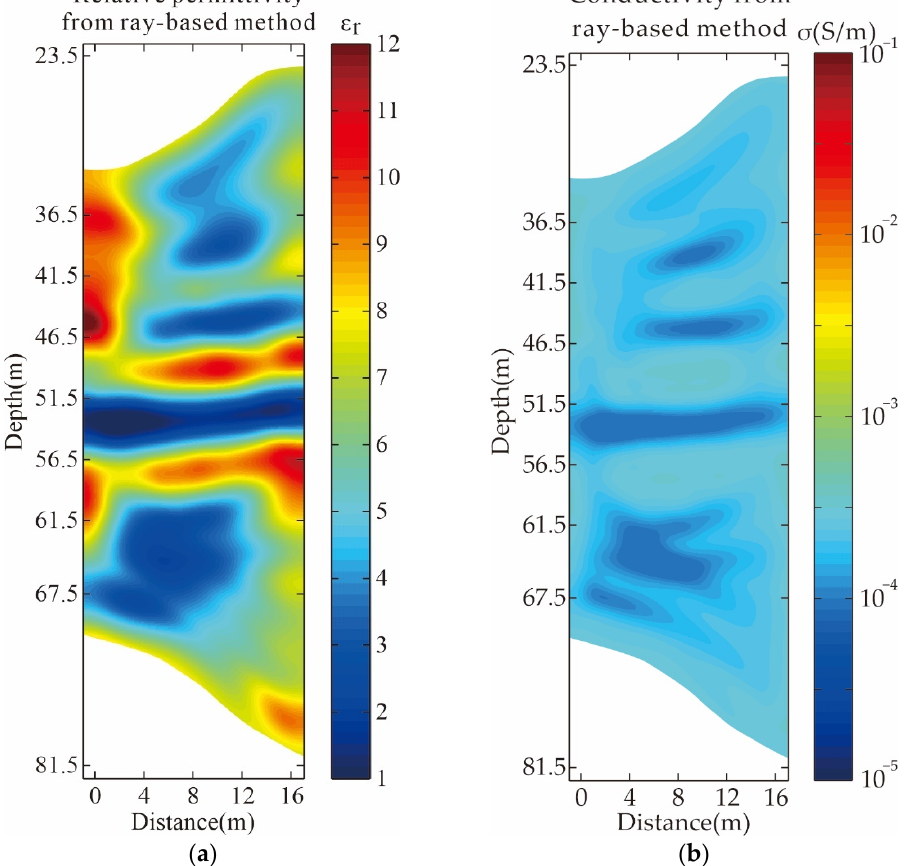
Figure 11. Inversion results of Xiuyan GPR data based on ray theory: ( a ) relative permittivity; ( b ) conductivity.